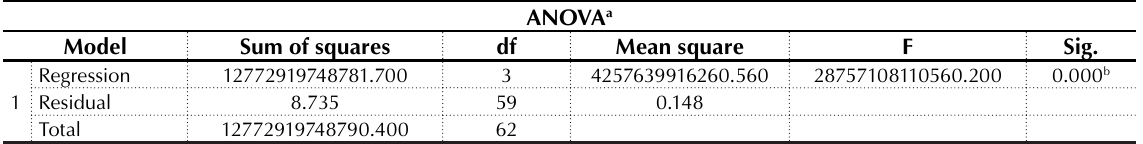
Table 2. ANOVA test for overall significance